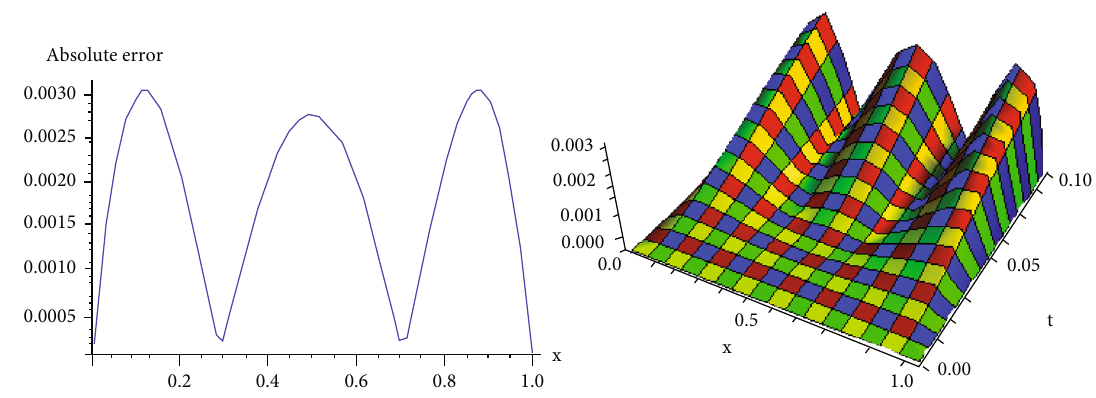
Figure 12: 2D and 3D error pro fi les for Example 8 when h = 1/60, t = 0 : 1, Δ t = 0 : 01